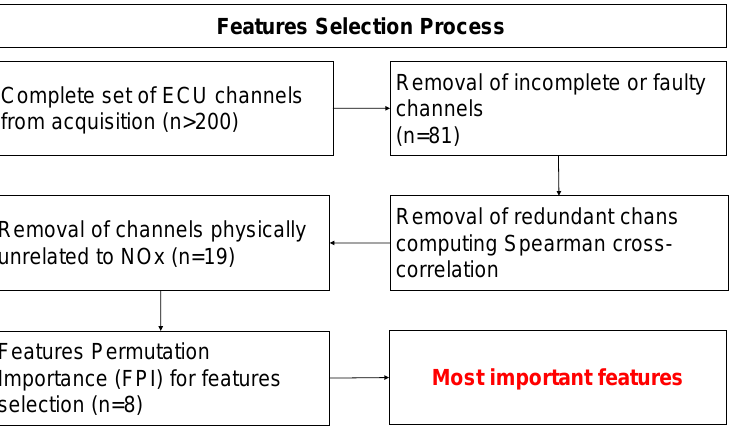
Figure 8. Flow chart of main feature selection steps.